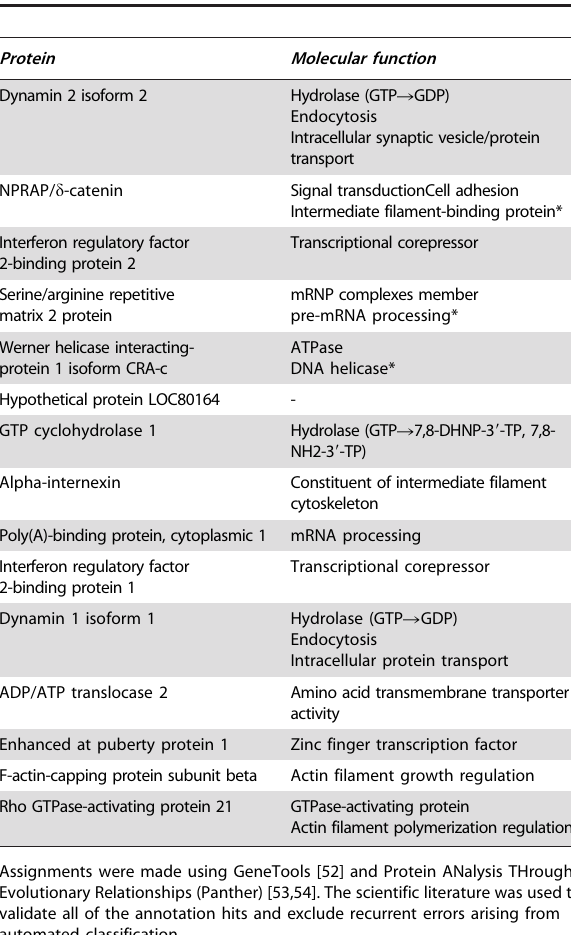
Table 2. Functional annotations of NPRAP-interacting proteins.